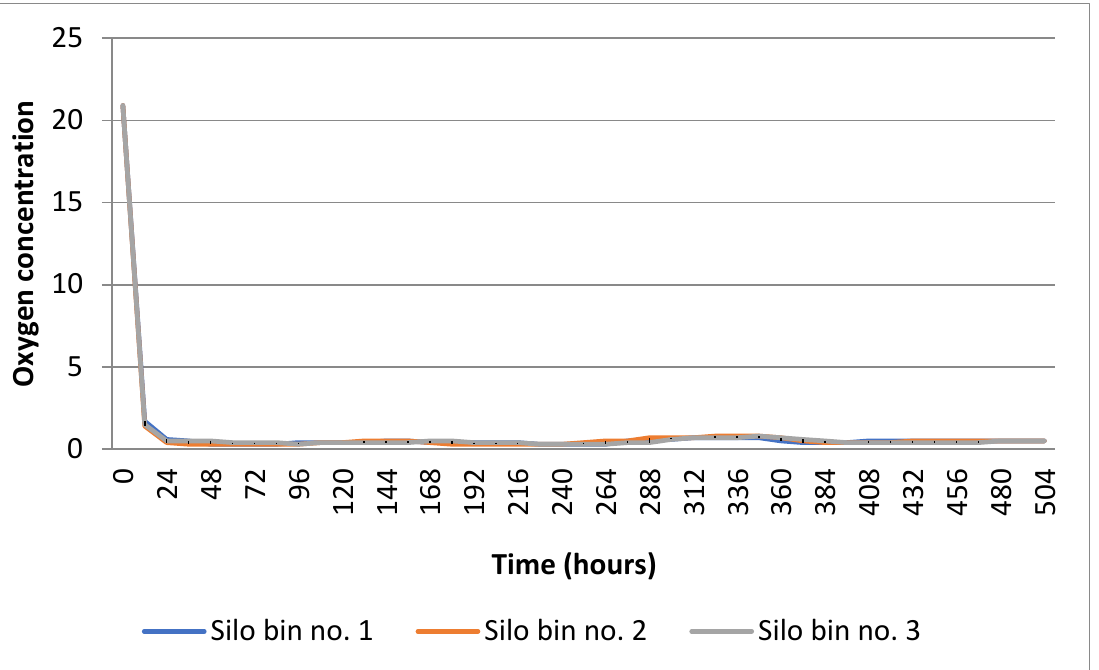
Figure 4. Oxygen concentration during field test — 20 + 1 days of exposure (n = 3 silo units); 1 day N 2 purging; 20 days full N 2 concentration exposure. The average oxygen concentration after initial 12 h nitrogen purging was 1.5 ± 0.1%; the average oxygen concentration for the 20 days of nitrogen maintenance was 0.5 ± 0.0%.